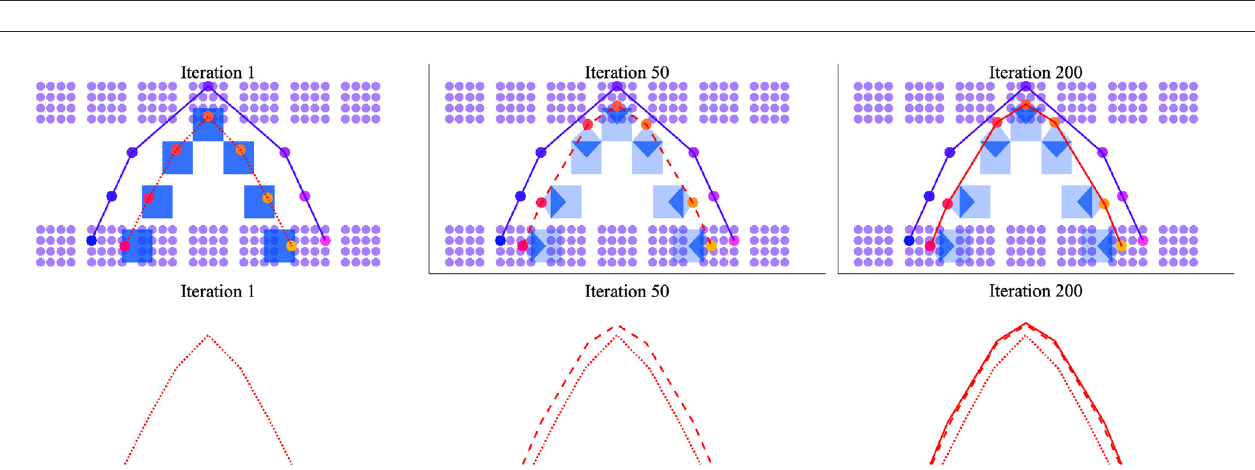
FIGURE8 Change in output trajectory over time with iterations of practice in a 2D perceptual-motor space where the perceptual and motor spaces have identical layouts. (Upper) Silhouettes are shown as blue squares (left) or blue polygons of varying-opacity (center and right) to indicate weighting; the exemplar trajectory is traced in purple; the output trajectory in red. (Lower) The output trajectory is depicted after 1 iteration (dotted line), 50 iterations (dashed line), and 200 iterations (solid line). Reading from (left-to-right) , the output trajectory is shown to change shape to better approximate the exemplar trajectory over